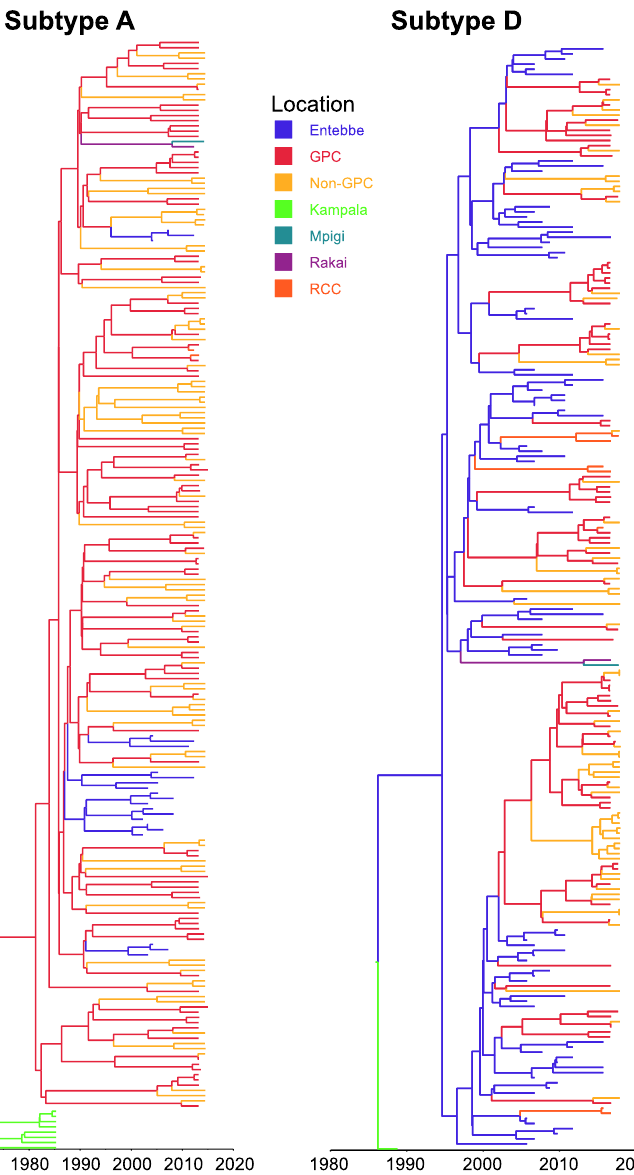
Figure 1. Location-annotated Maximum Clade Credibility (MCC) trees. ( Subtype A ) MCC tree reconstructed from HIV-1 pol subtype A sequences from the GPC, areas outside but neighbouring the GPC (non-GPC), historical sequences obtained during 1986 (Kampala) and from other sites (Entebbe, Mpigi, Rakai, rural clinical cohort; RCC). ( Subtype D ) MCC tree reconstructed from HIV-1 pol subtype D sequences. The corresponding estimated times to the most recent common ancestor (TMRCA) were 1972 (1961 – 1975) and 1985 (1979 – 1987) for subtype A and D respectively. The branches on the tree are coloured according to the location and the time scale at the bottom is in calendar years.